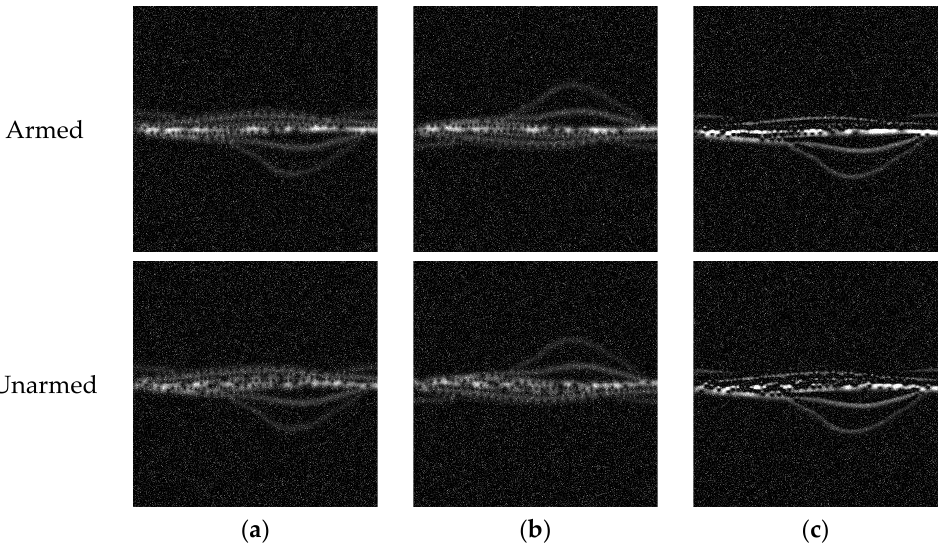
Figure 15. Generated samples obtained by the affine+sharpening method using the modified Boulic model. ( a ) The original image; ( b ) affine (reflex); ( c ) sharpening.